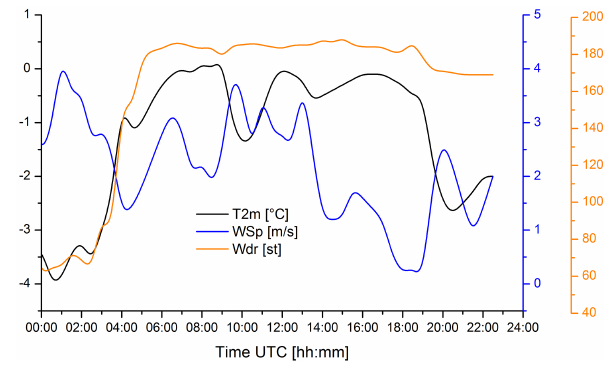
Figure 2. Temperature change ( T 2m ), wind speed ( W Sp ) and wind direction ( W dr ) measured at AMP Otlica during the 15 January 2013 snowstorm.